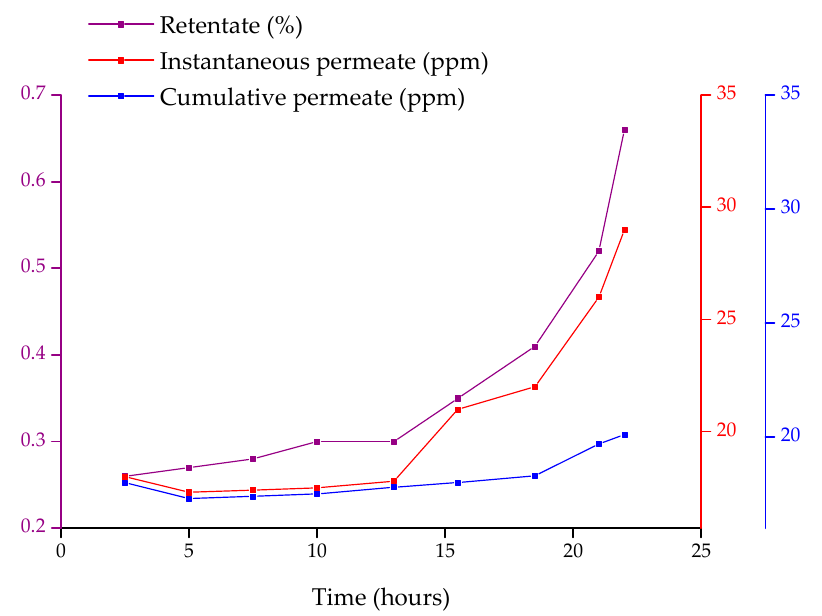
Figure 6. The variation in iron concentration in retentate, instantaneous permeate and cumulative permeate as a function of time.